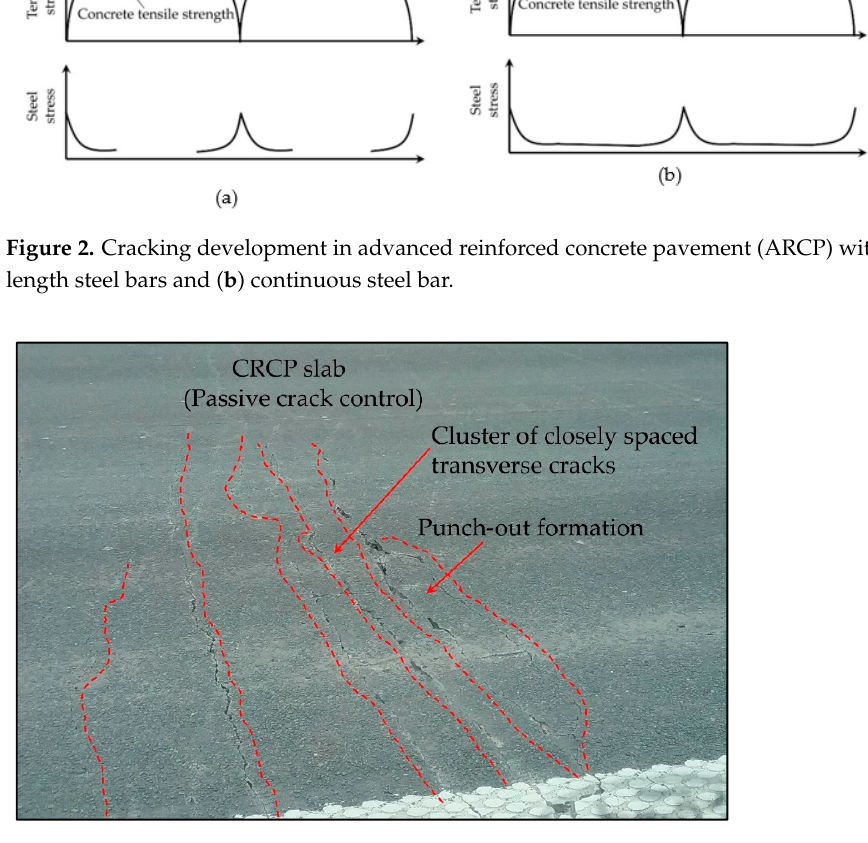
Table 1. Overview of design concepts for continuously reinforced concrete pavement (CRCP) in Belgium.